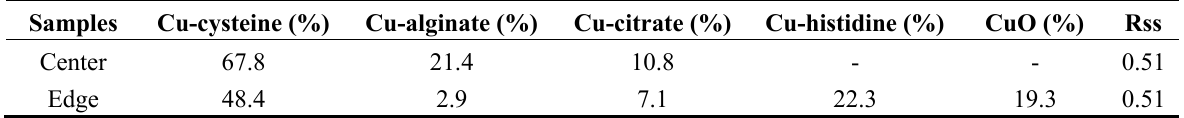
Table 1. The results of fitting the micro-XANES spectra with a linear combination of the measured data sets of representative model compounds. Copper oxidation states were assigned according to the similarity of the absorption edge energies of reference compounds. Rss: residual sum of